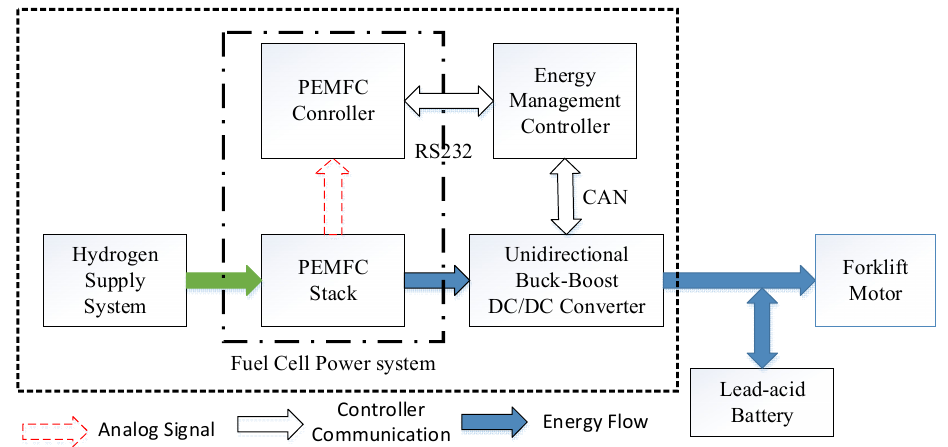
Figure 2. Fuel cell/battery hybrid power system.